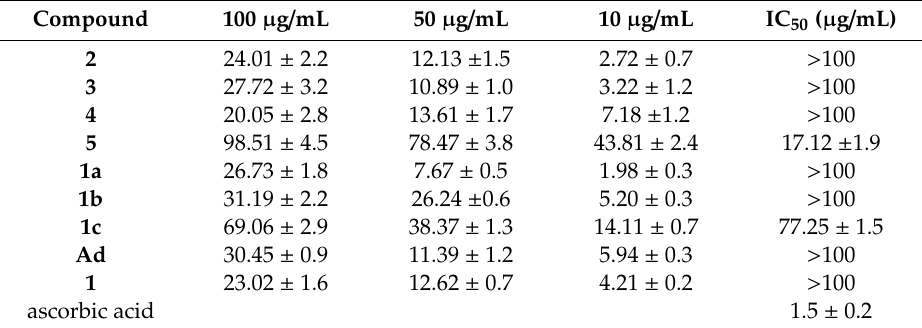
Table 1. Percentage (%) of de-coloration of the DPPH solution and IC 50 values in µ g / mL for synthetic compounds in comparison to ascorbic acid. Values are averages of triplicate experiments.